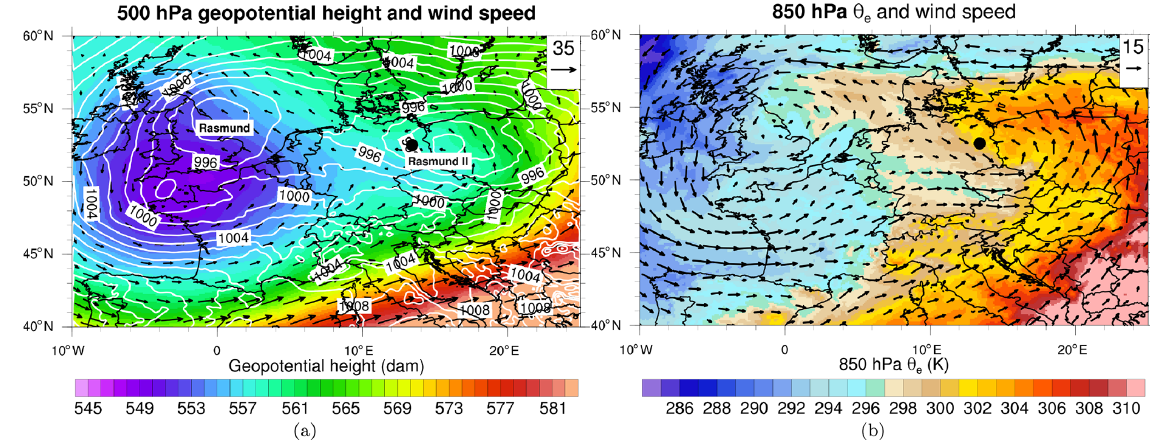
Figure 3. (a) 500hPa geopotential height (dam; colour) and wind speed (ms − 1 ) together with sea level pressure (hPa; contours) and (b) 850hPa equivalent potential temperature ( θ e ) and wind speed on 29 June 2017 12:00UTC from the ECMWF analysis. The black dot denotes the city of